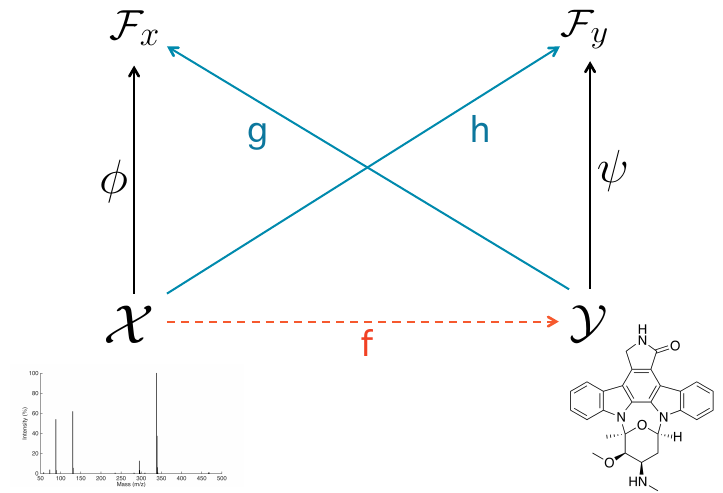
Figure 1. Schematic illustration of IOKR and IOKRreverse approaches. IOKR learns a function h to map MS/MS spectra to a molecular feature space the molecular structures to a MS/MS feature space